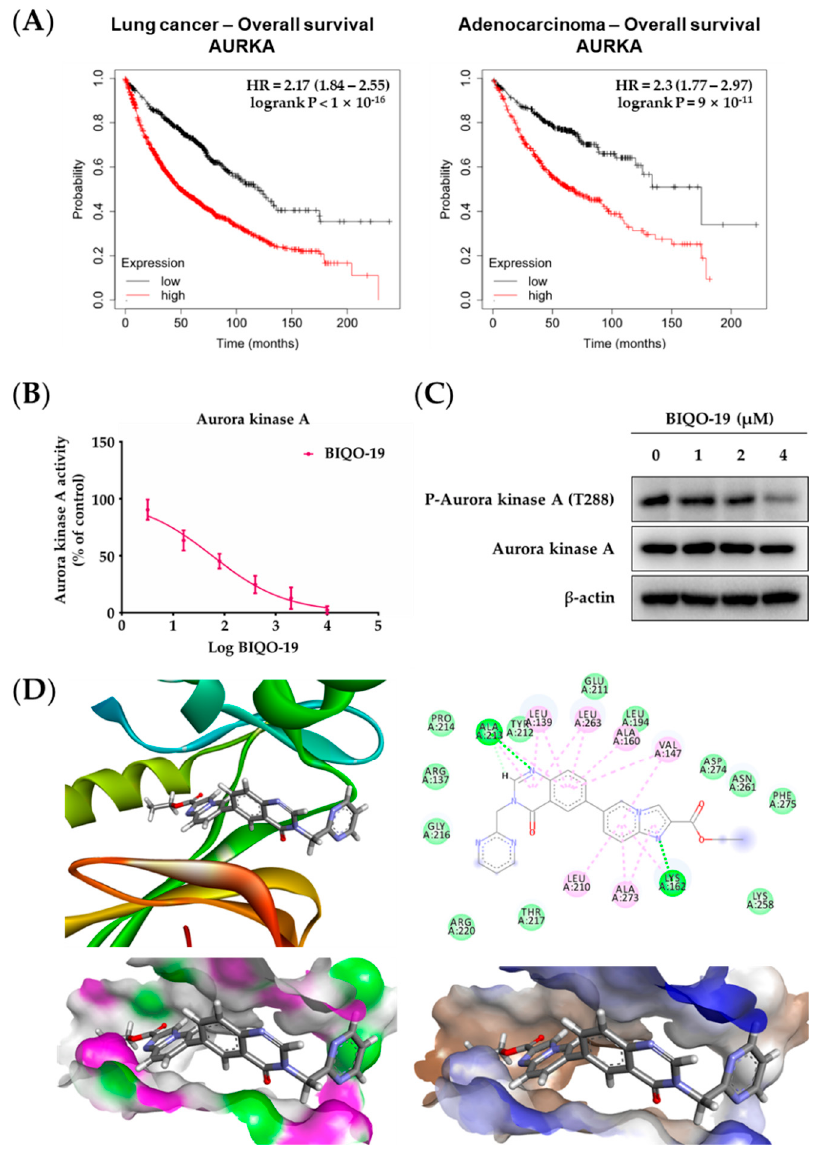
Figure 3. Correlation between expression level of aurora kinase A and overall survival in lung cancer and the effects of BIQO-19 on aurora kinase A activity and expression in H1975 cells. ( A ) The overall survival (OS) curves for lung cancer (left panel) and adenocarcinoma (right panel) with aurora kinase A expression level were analyzed using the Kaplan–Meier method. ( B ) The cell-free enzymatic activity of aurora kinase A was analyzed as described in the Methods section. Data are presented as the means ± standard deviation (SD) from three independent experiments. ( C ) H1975 cells were treated with BIQO-19 for 24 h and the levels of phospho-aurora kinase A (T288) expression were analyzed by Western blotting analysis. β -Actin was used as an internal control. ( D ) Molecular modeling of BIQO-19 and aurora kinase A (PDB ID: 6C2T) binding simulation were carried out in a docking study, as described in the Methods.